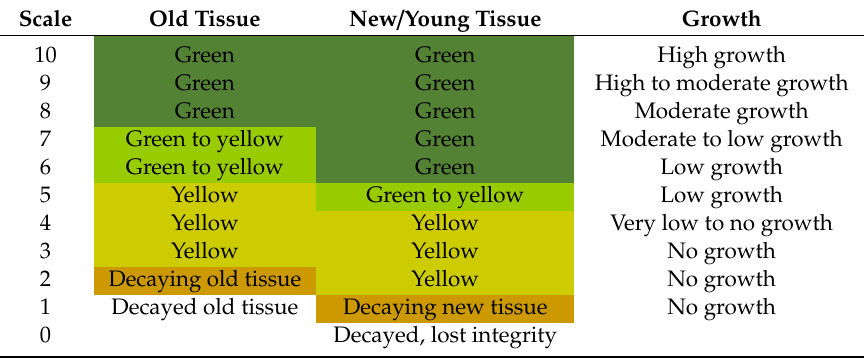
Table A1. Guideline for assigning visual quality scores to plants (0–10).